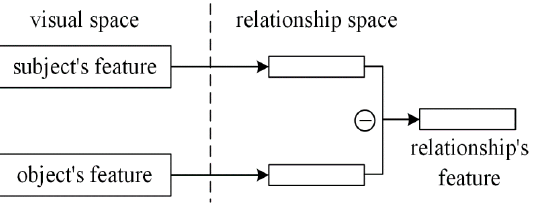
Figure 3. The process of the semantic transformation module of VTransE.